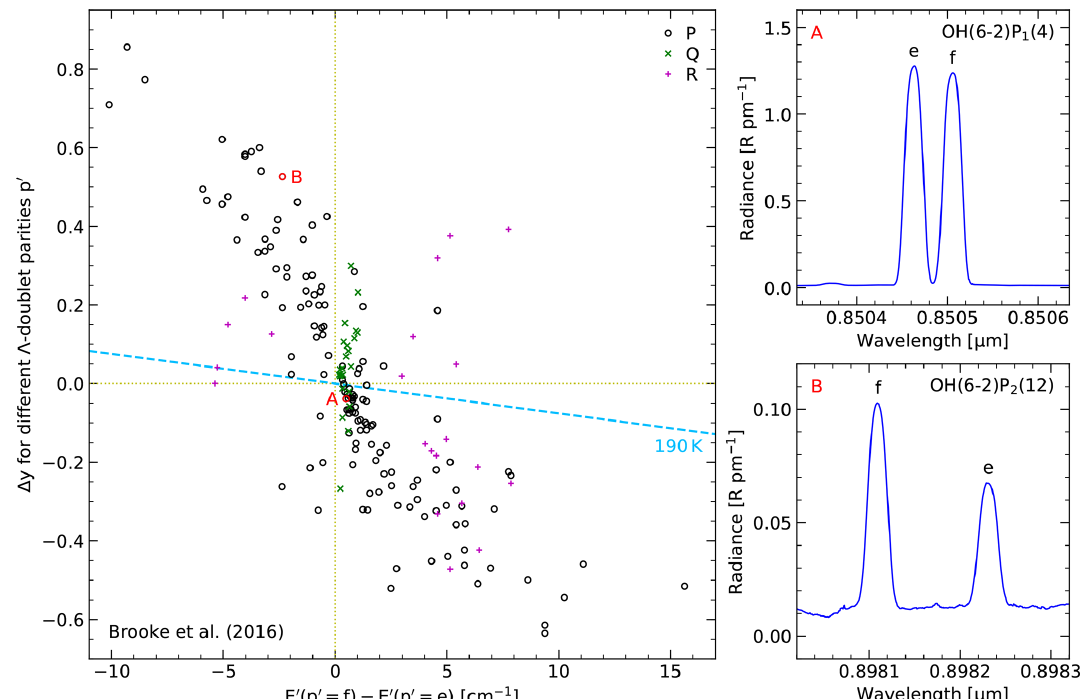
Figure 9. Difference in logarithmic OH level populations (cid:49)y of the separately measured components of reliable (cid:51) doublets indicated by the upper-level parity f and e as a function of the corresponding difference in the upper-level energy E (cid:48) . The results for different branches ( P , Q , and R ) are marked by different symbols and colours (see the legend). Examples for small and large population discrepancies are marked by the letters A and B. On the right-hand side, the corresponding (cid:51) -doublet spectra are plotted with indicated line identifications. The dashed line in the main plot indicates the effect of a thermal population with a temperature of 190K on (cid:49)y